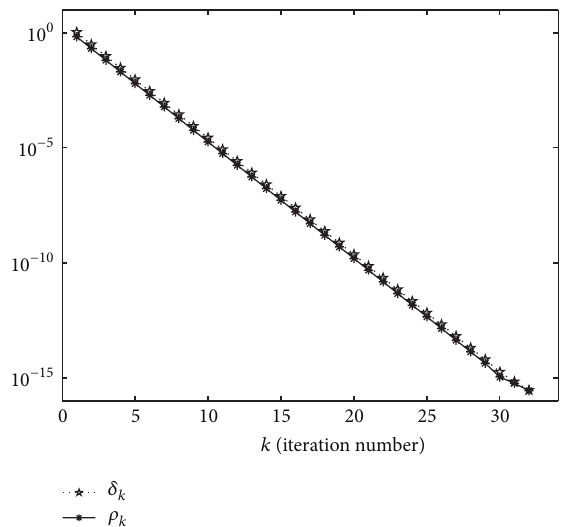
Figure 2: ‖𝑌 𝑘+1 − 𝑌 𝑘 ‖ 𝐹 and ‖𝑍 𝑘+1 − 𝑍 𝑘 ‖ 𝐹 for Example